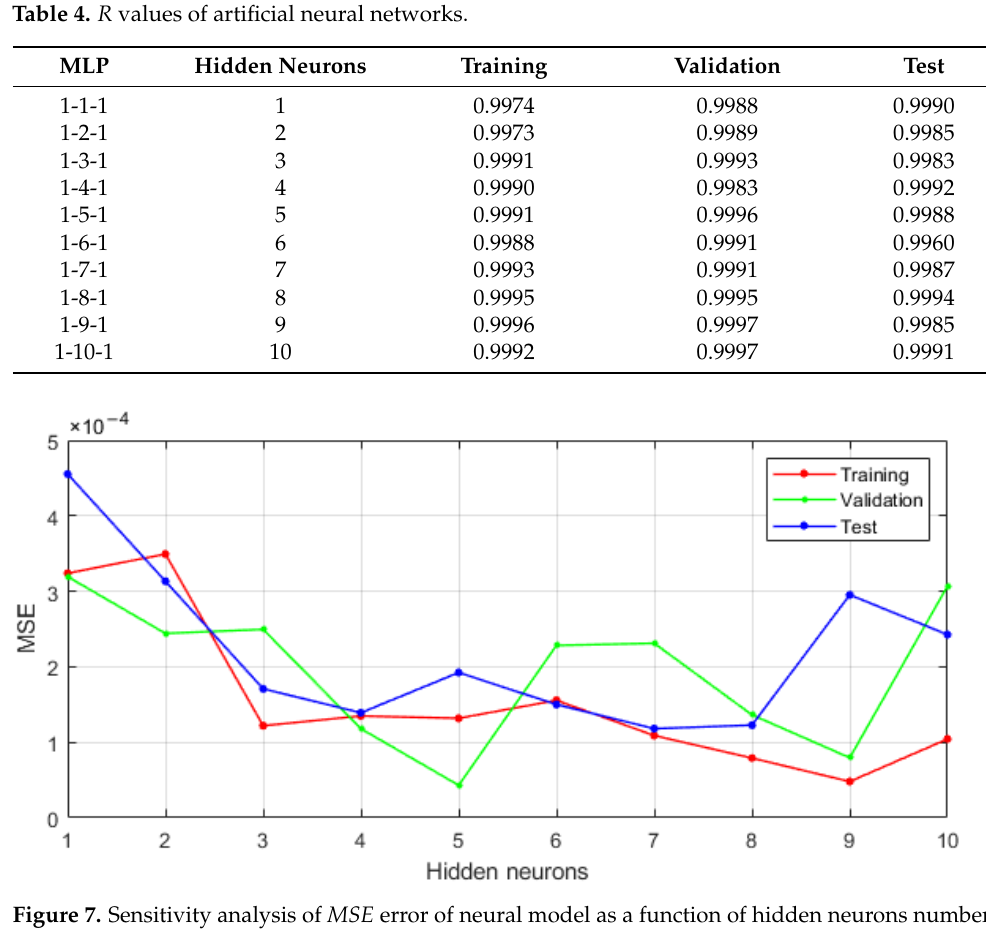
Figure 8. Analysis of sensitivity of R correlation coefficient in neural model as a function of hidden neurons number. The analysis of the MSE error values and the R correlation coefficient presented in Figures 7 and 8 show a slight improvement in the degree of fitting of the neural model to the estimated values of the reliability function. The graphs shown in Figures 9 and A1 – A9 (Appendix A) illustrate the approximation of the reliability function by neural models with a number of neurons in the hidden layer ranging from 1 to 10. While the number of hidden neurons increases, the model tends to interpolate the function. For a developed model based on 9 and 10 neurons, the approximating function takes a non-monotonic form and therefore does not satisfy the condition of non-increasing reliability function. The uncomplicated form and good fit of the MLP 1-1-1 model led us to choose this neural network as the suitable one for further analyses and considerations. Figure 9 shows the course of the reliability function approximation curve in the MLP 1-1-1 neural model together with the estimated values and the difference between the es- timated value and the modelled value. The degree of fitting in each dataset together with scatter plots are shown in Figure 10. The similar values of the R correlation coefficient indicate a valid approximation, without the occurrence of network overtraining and fit- ting only to the data from the training set.